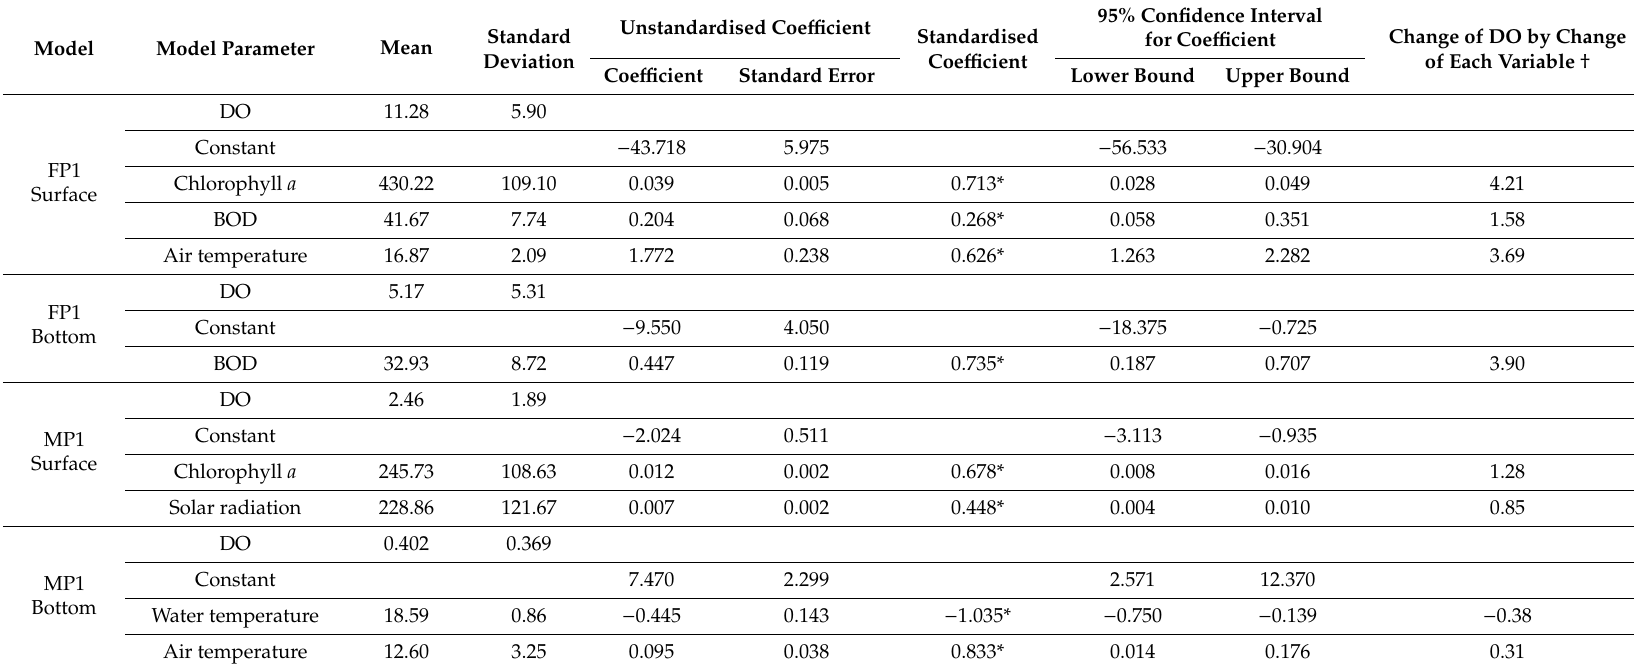
Table 2. Model parameters and the importance of the predictor